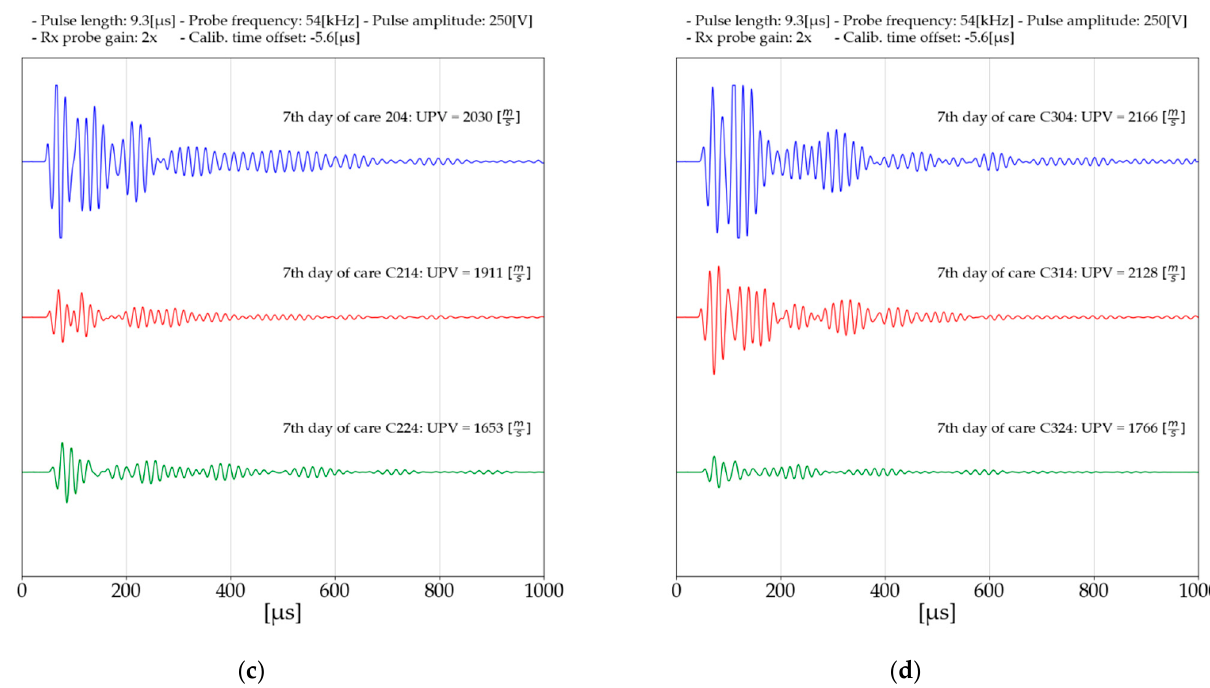
Figure 6. Received waves during Ultrasonic pulse velocity test—day 7 of curing period: ( a ) Mixtures without polypropylene fibers; ( b ) mixtures with 3% binder; ( c ) mixtures with 5% binder; ( d ) mixtures with 7% binder.